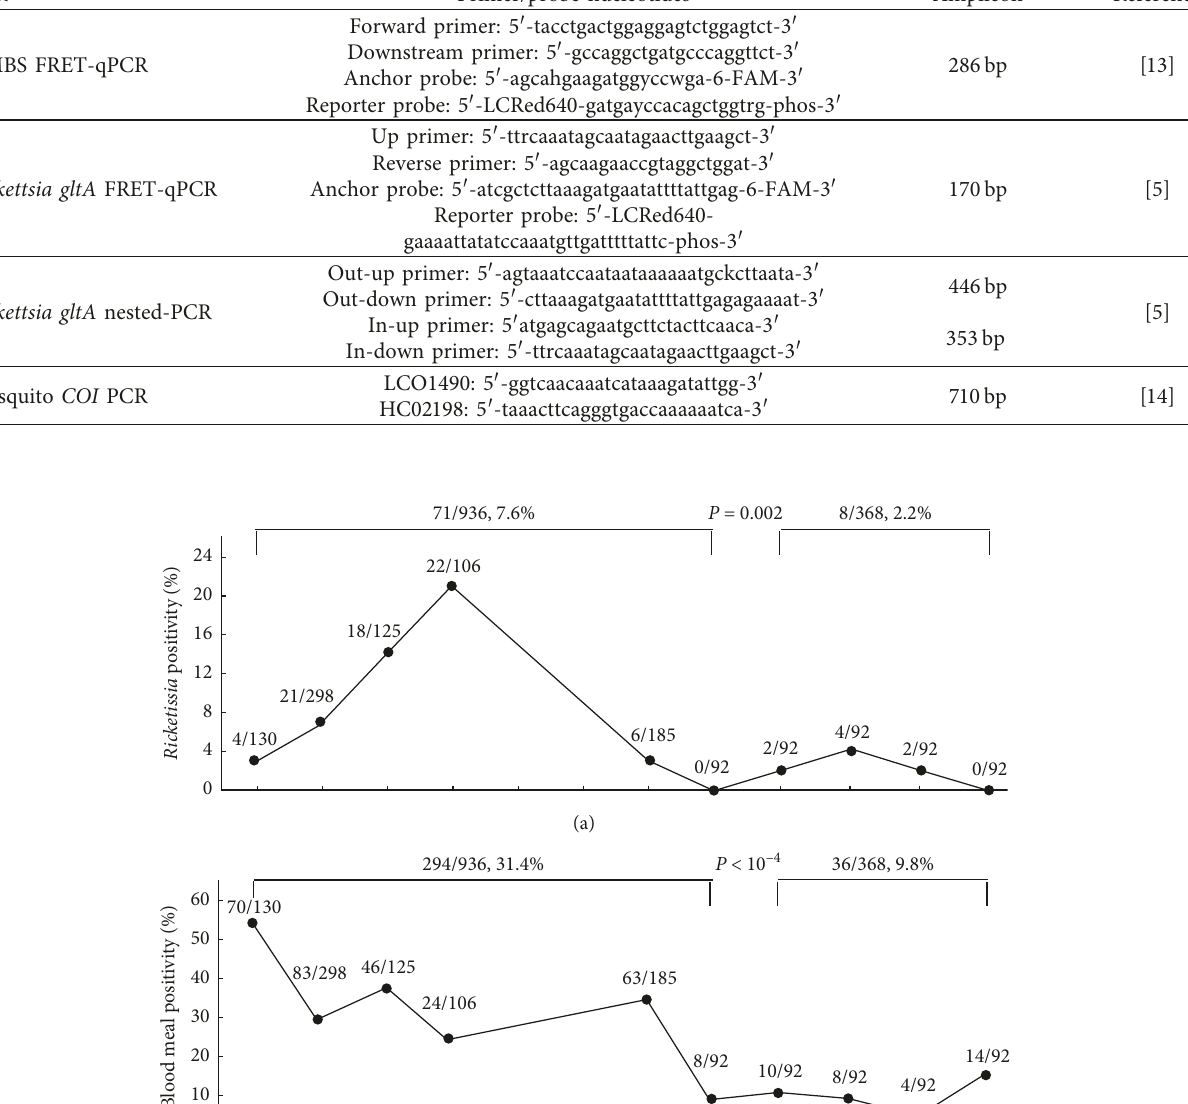
Table 1: Primers and probes used in the PCR reactions in this study.